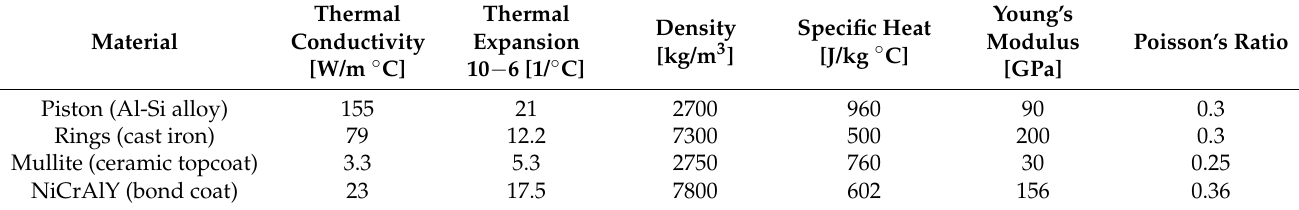
Table 2. Material properties